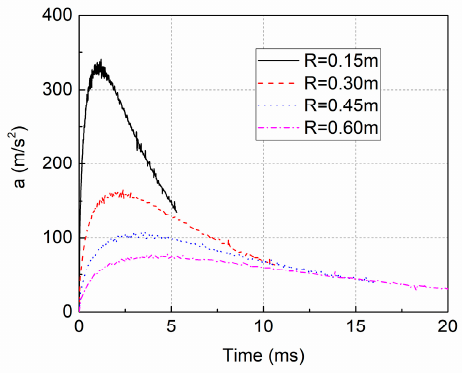
Figure 13. The time history of the acceleration with different radii.